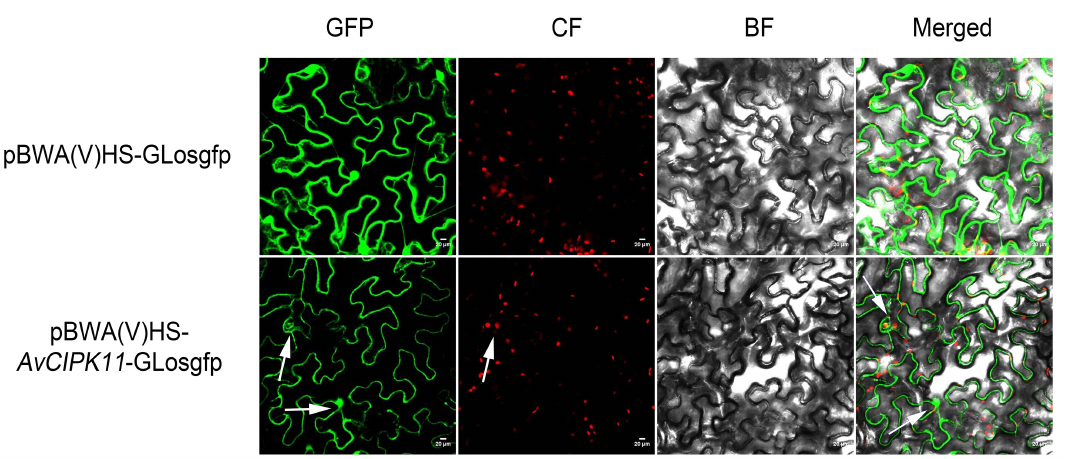
Figure 5. Subcellular localization analysis of the AvCIPK11 protein. GFP: Green fluorescence protein; CF: Chloroplast fluorescence; BF: Bright field; Merged: Merged field for GFP and CF. The scale bar was set at 20 µ m. Arrows represent where the protein is